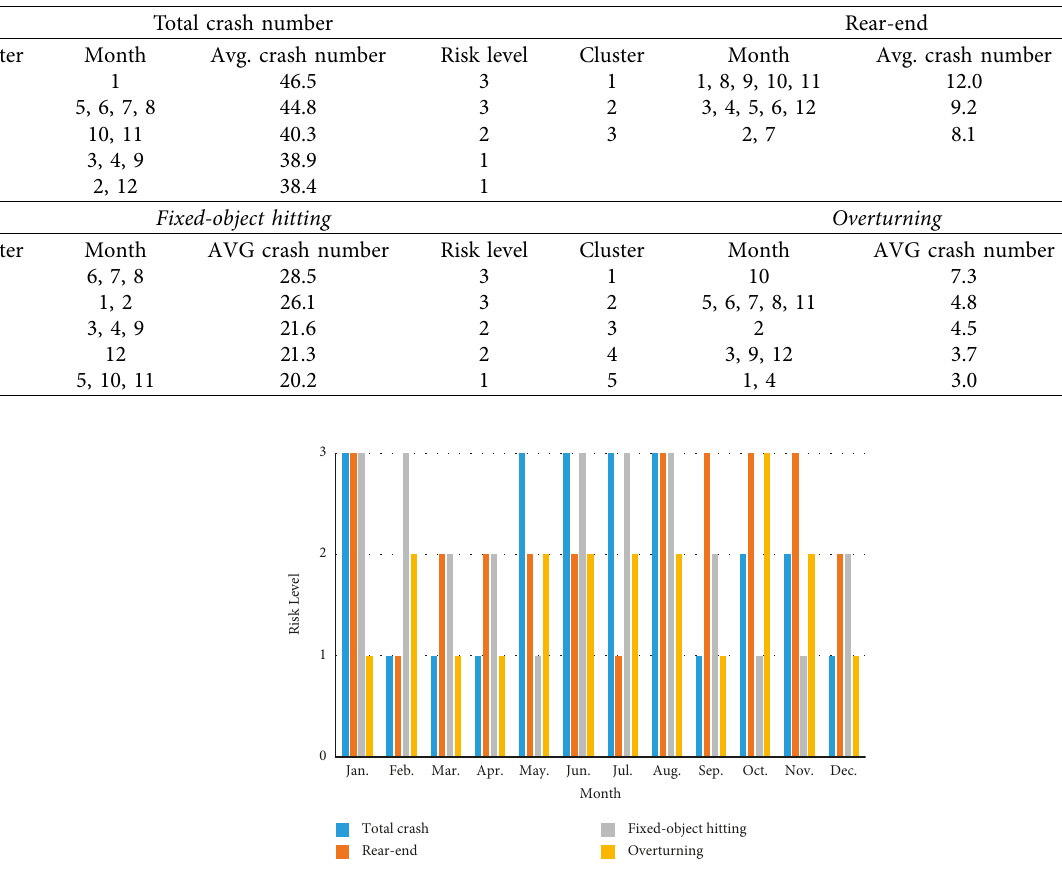
Table 1: Results of K -means clustering.